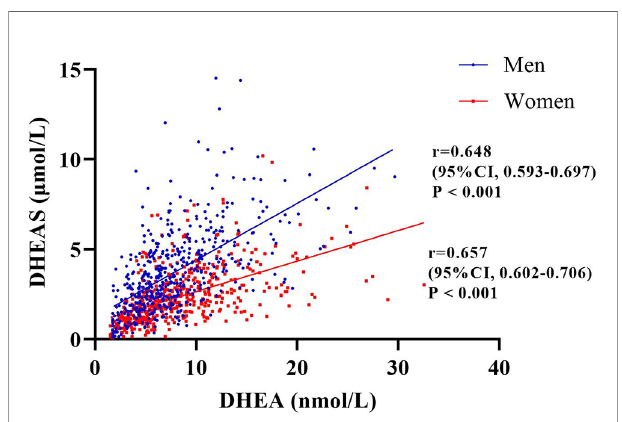
FIGURE 2 | Correlation between serum dehydroepiandrosterone (DHEA) and dehydroepiandrosterone sulfate (DHEAS) among the men and women included in this study evaluated by Spearman ’ s correlations. The fi gure indicates that the serum levels of DHEA and DHEAS were highly collinear (among men: r = 0.648, 95% CI = 0.593 – 0.697, p < 0.001; among women: r = 0.657, 95% CI = 0.602 – 0.706, p < 0.001).